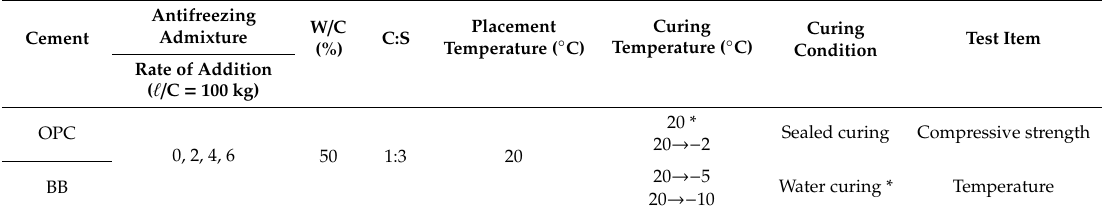
Table 1. Experiment plan.